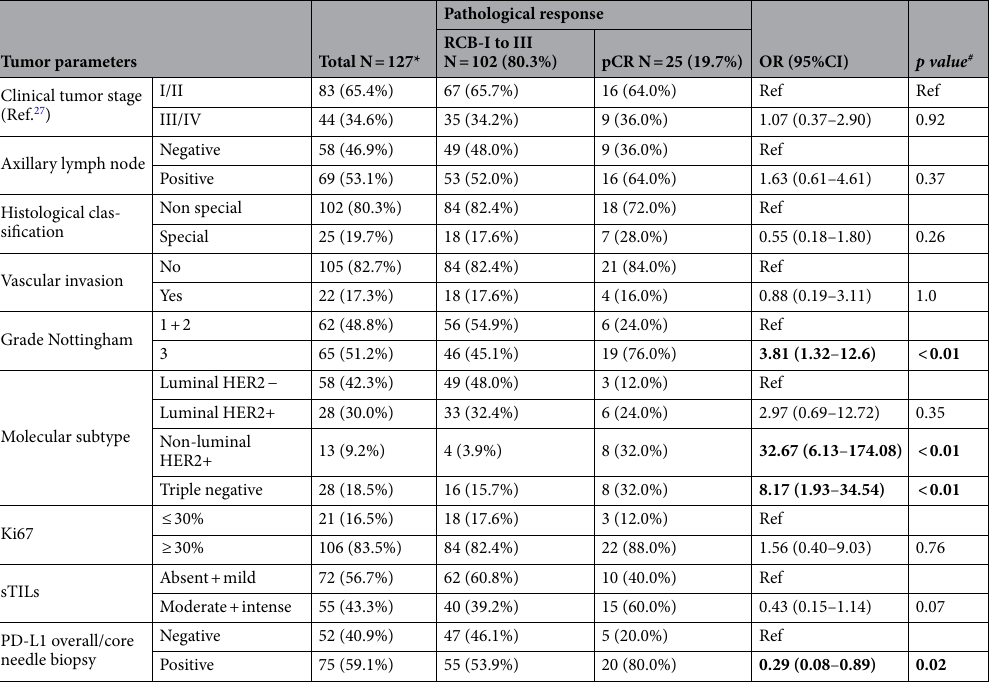
Table 3. Correlation between pretreatment tumor parameters and pathological response post neoadjuvant chemotherapy. Values in bold indicate data of statistical significance. *Three women had bilateral breast carcinoma; pCR: pathological complete response; RCB: residual cancer burden; sTILs: stromal tumor infiltrating lymphocytes; Ref: reference value; In one case immunohistochemistry and FISH for HER2 was inconclusive. In ten cases HER2 was not expressed through immunohistochemistry and or FISH, in percutaneous needle core biopsies (pre-treatment specimens), and was positive in the surgical specimens after NACT (post-treatment specimens). Of the 75 positive cases for PD-L1, 35 expressed as much in the epithelium as in the stroma, 5 expressed only in the epithelium and 35 only in the stroma. We next fit a regression model including all variables with p < 0.10 (Grade—Nottingham, molecular subtype, sTILS and PD-L1); after adjustment, high histological grade, non-luminal HER2+ and triple negative carcinomas remained significantly associated with pCR: OR = 3.50, 95%CI = 1.28 to 10.7; p = 0.01; OR = 1.82, 95%CI = 4.41 to 90.7; p < 0.01 and OR = 5.0, 95%CI = 1.43 to 17.47; p = 0.01. # p value calculation using Fisher´s exact test and logistic